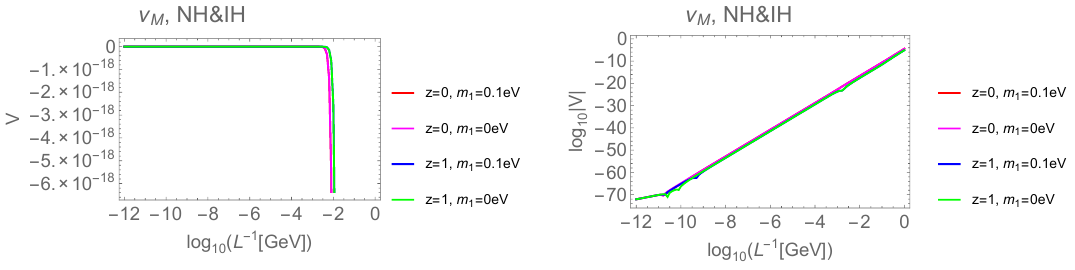
Figure 5 . The potential is the same as the upper right panel of (cid:12)gure 4, but the vertical axes are V (left), and log j V j (right), respectively. Here the scale L 0 is taken to be 1 GeV (cid:0) 1 10